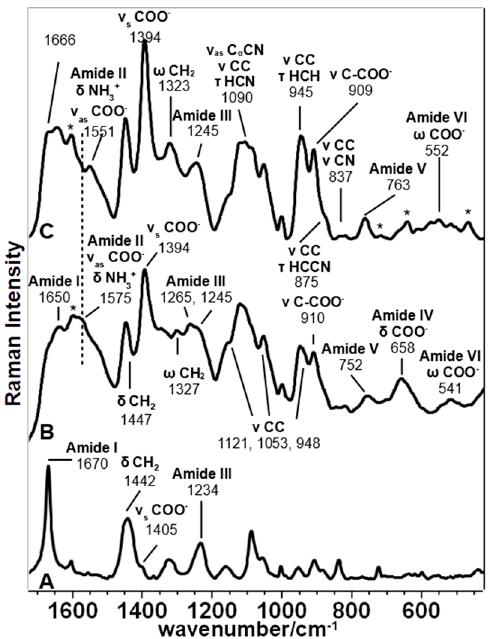
Figure 4. Comparison of the Raman spectrum (A) and SERS spectra of Pept3 as-synthesized (B) and after irradiation (C). Asterisks (*) were used to indicate the bands attributed to FMOC or the solution’s contaminant.